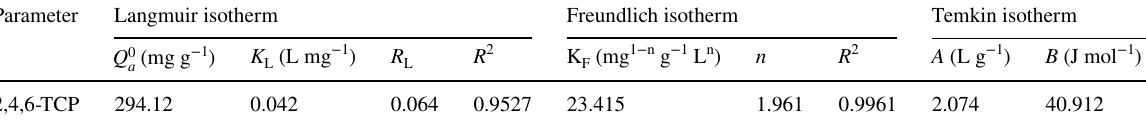
Table 8 Comparison of maximum monolayer adsorption capacity of 2,4,6- TCP adsorption on different